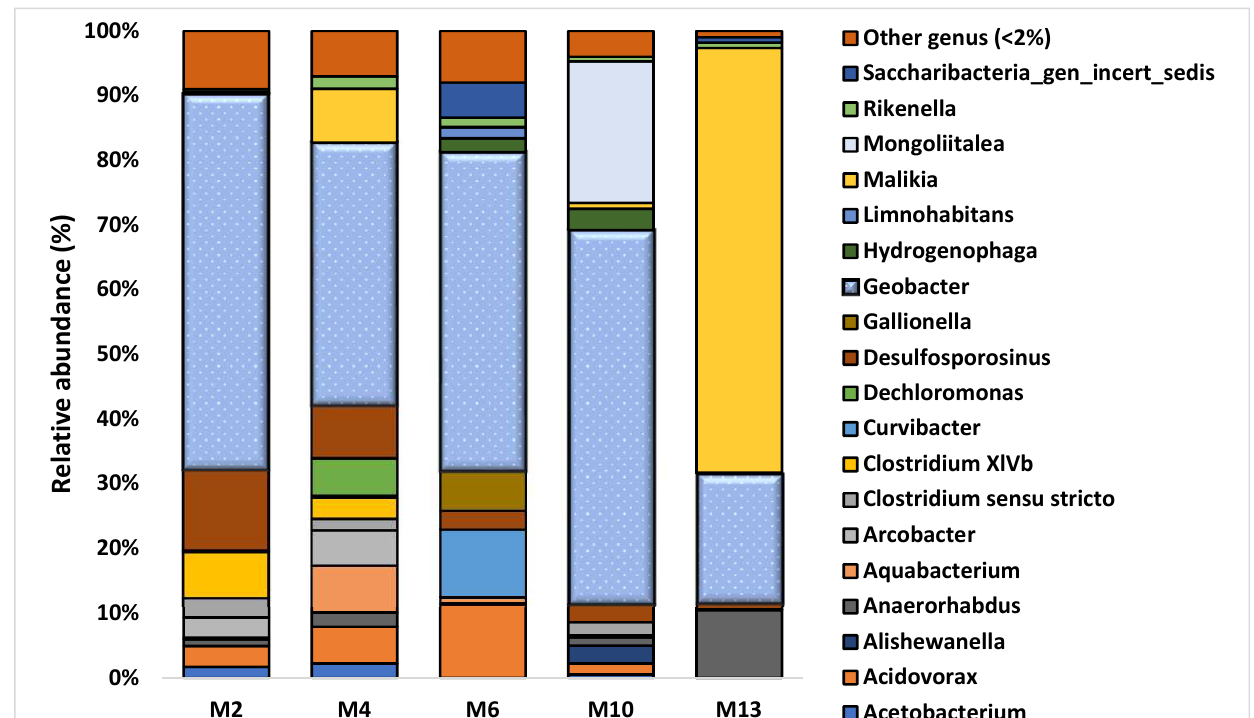
Figure 7. Illumina sequencing results: composition and relative abundance of the species identified in five representative wells in the pilot test area. Geobacter spp. (light blue with white points) is the strain mainly represented.